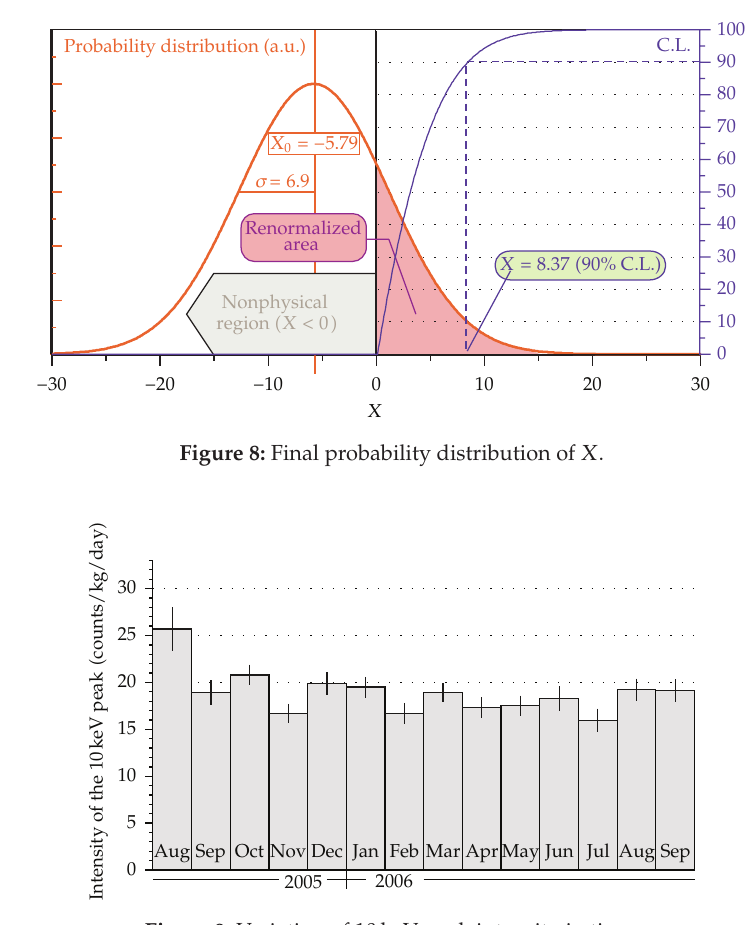
Figure 9: Variation of 10keV peak intensity in